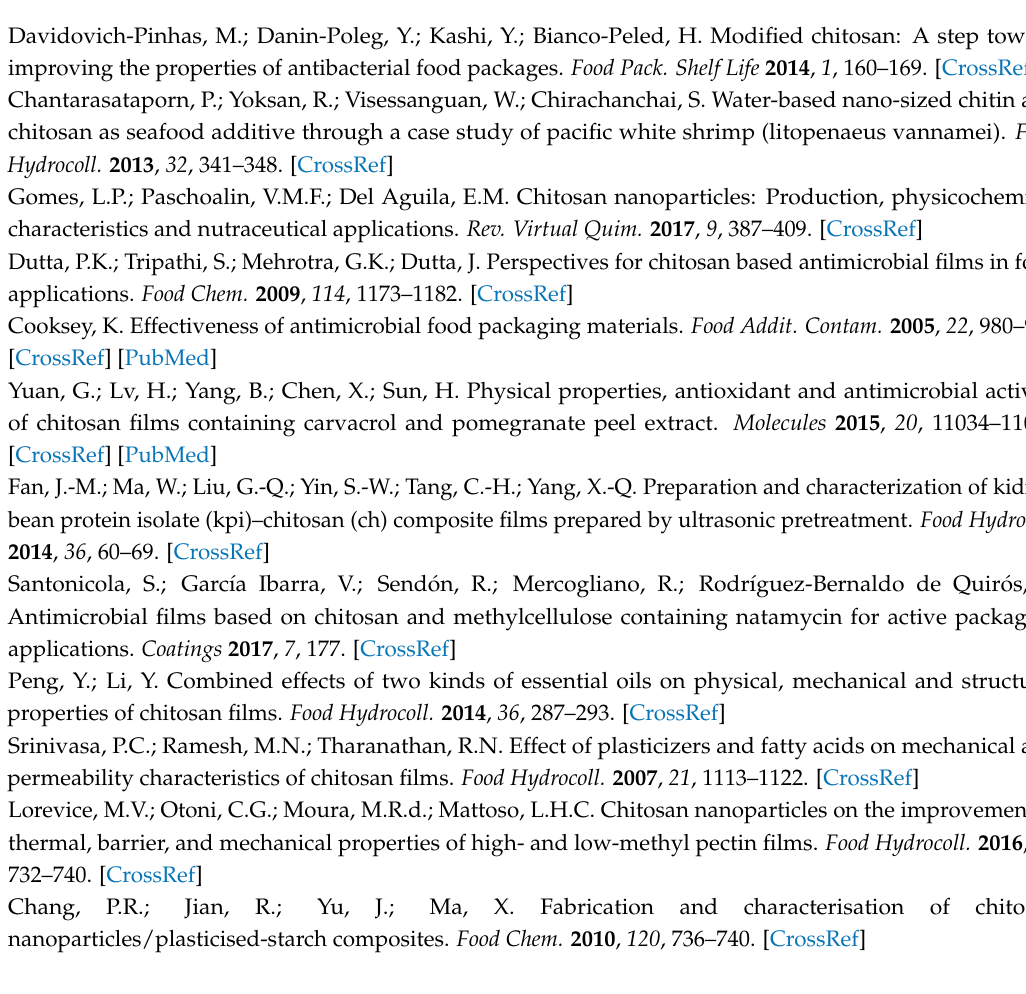
Supplementary Materials: The following are available online, Figure S1: Stress curve for the sample NS/S(5min)—7:3, Table S1: Tensile strength (TS) properties of chitosan biobased films prepared from